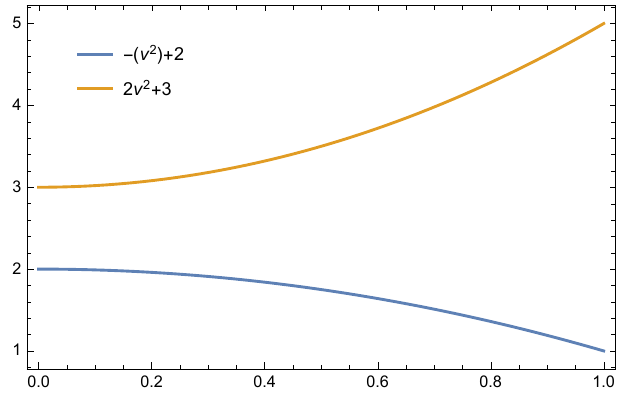
Figure 1. Graphical behaviour of the CR interval valued convex functions given in Example 1.